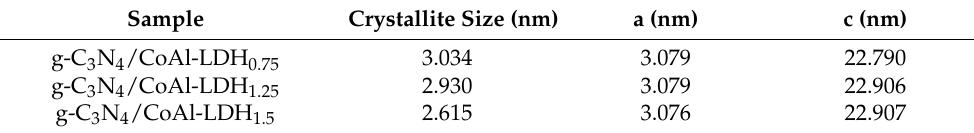
Table 1. The crystallite size and unit cell parameters of the g-C 3 N 4 /CoAl-LDH nanocomposites.